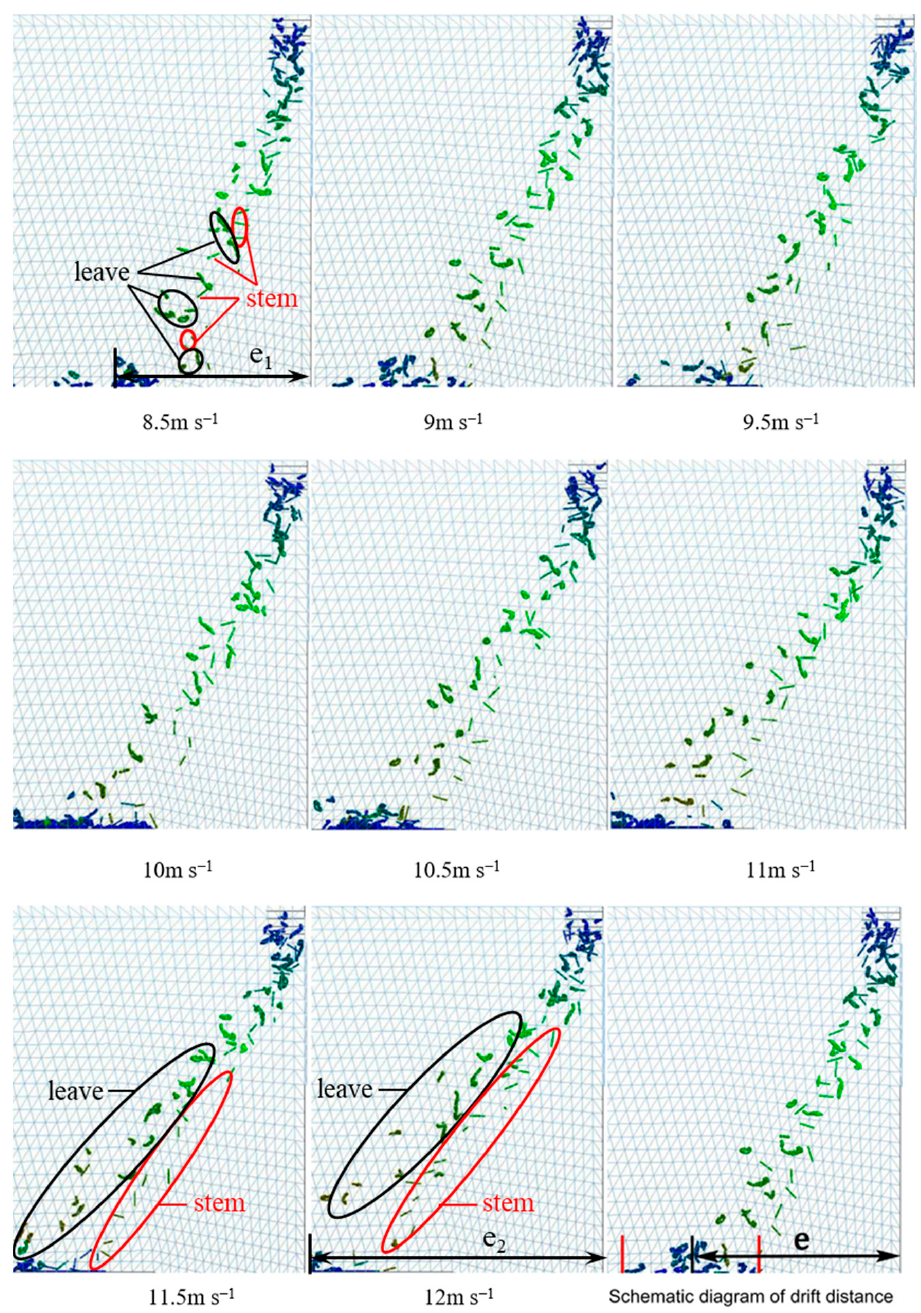
Figure 14. Particle dispersion at different wind speeds.